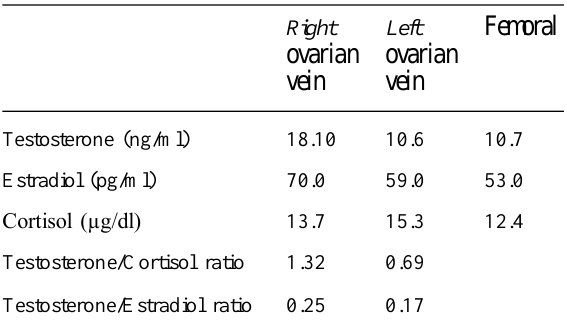
Table 1. Summary of the results of ovarian vein catheterization